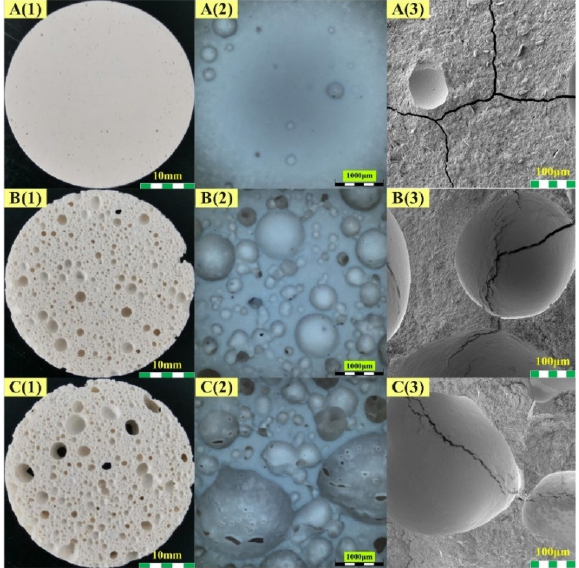
Figure 6. Morphology of matrix and geopolymer foams: ( A1 – A3 ) H0P0, ( B1 – B3 ) H2P0, ( C1 – C3 ) H3P0.